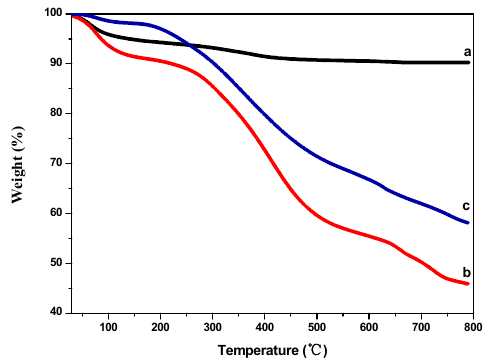
Figure 2. Thermogravimetric analysis graphs of (a) Fe 3 O 4 ; (b) Fe 3 O 4 @NC; (c) Fe 3 O 4 @NC/Pd.